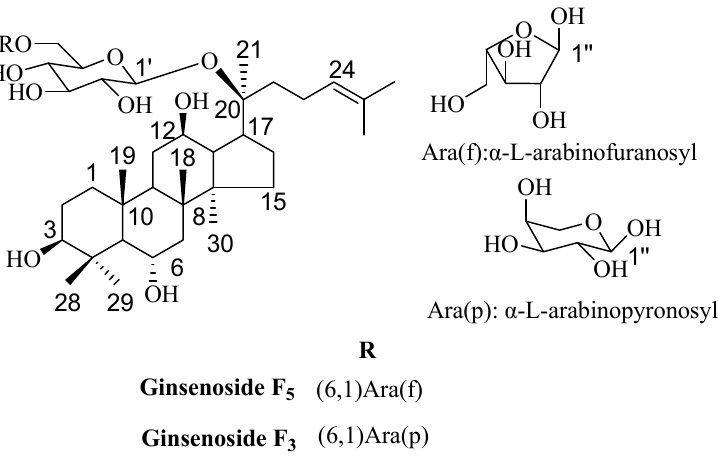
Figure 1. Chemical structures of ginsenoside F 5 and F 3 .